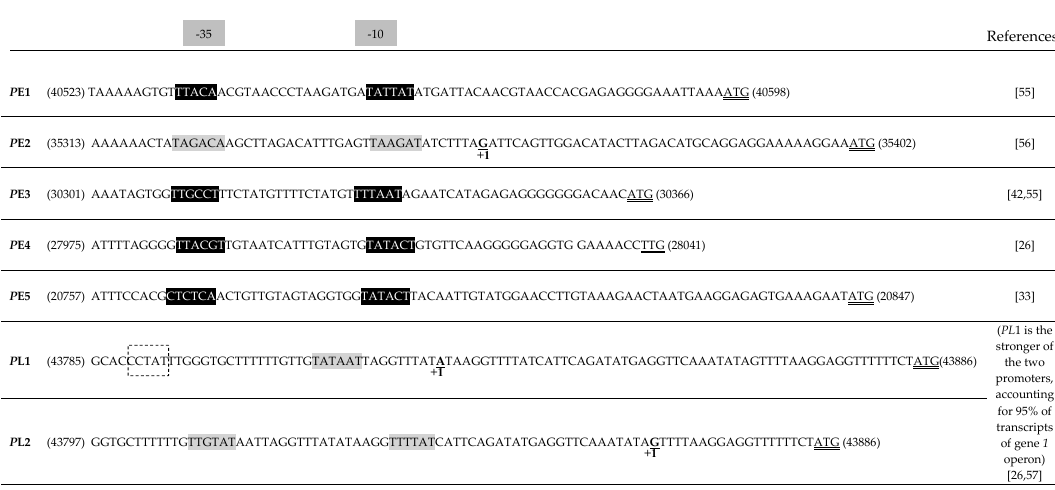
Figure 2. SPP1 promoters. The sequence of SPP1 promoters and the initiation codon of their downstream gene (double underline) are displayed. The − 35 and − 10 promoter regions are shaded in grey for promoters whose transcription start position (+1) was determined experimentally. A dashed box denotes the atypical − 35 sequence of P L1. SPP1 putative early promoters identified by sequence similarity to B. subtilis vegetative promoters are highlighted in black with sequence characters in white. Note that the approximate position of transcription initiation and promoter strength was determined for all early promoters by electron microscopy of DNA-RNA polymerase complexes